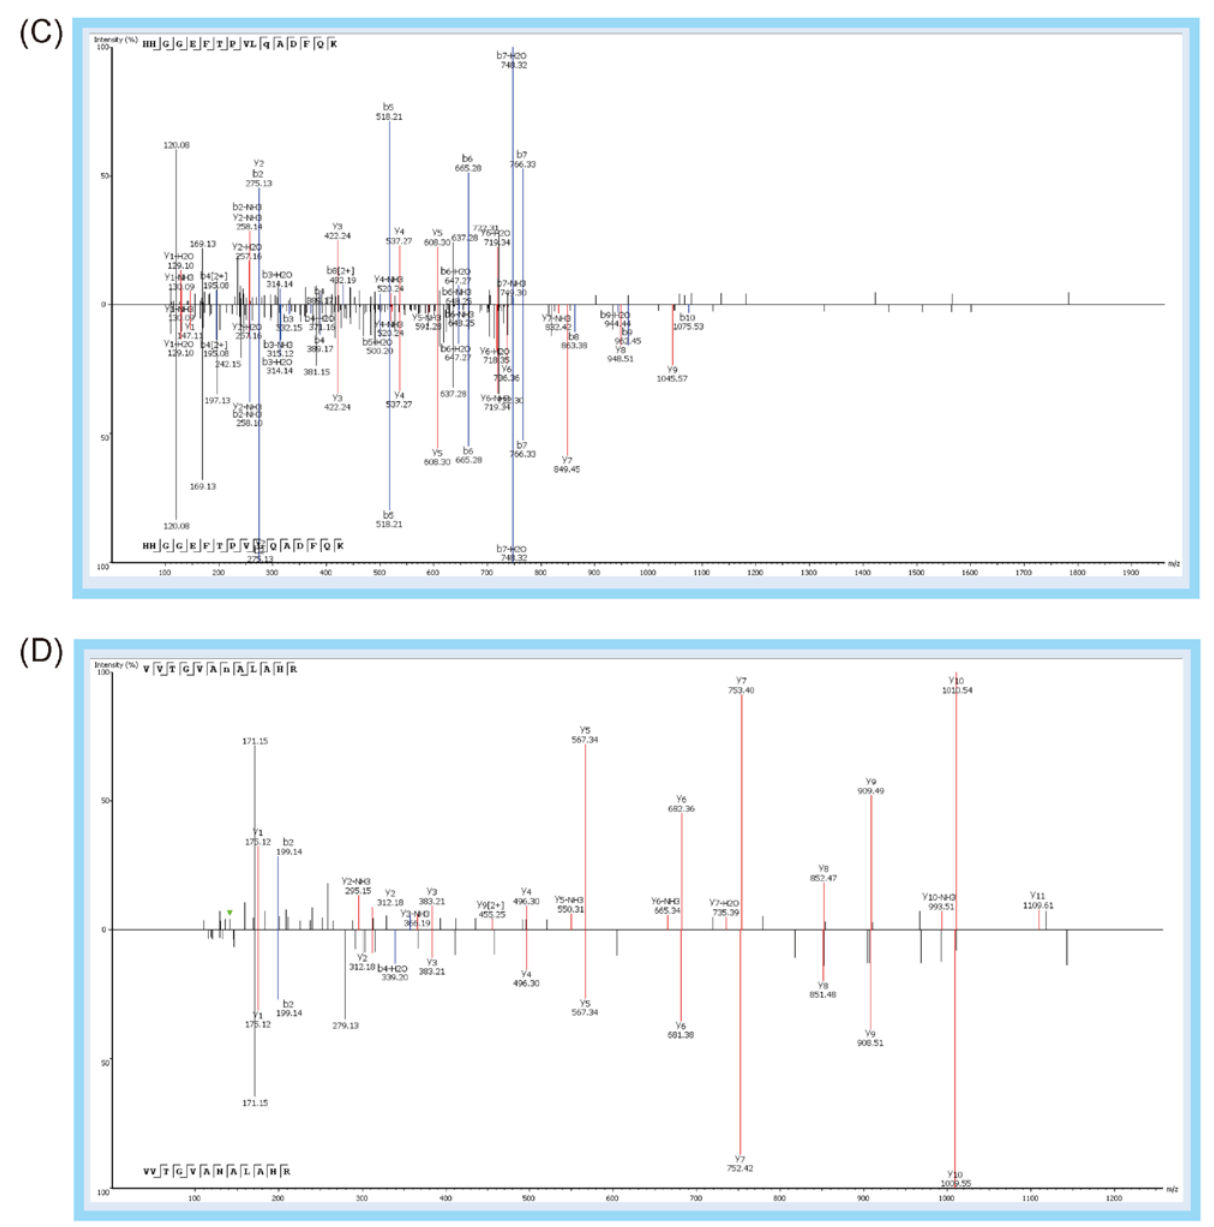
Figure 7. Comparison of sequence analysis maps after and before PTM of Pep 10 ( A ), Pep 11 ( B ), Pep 16 ( C ), and Pep 19 ( D ).